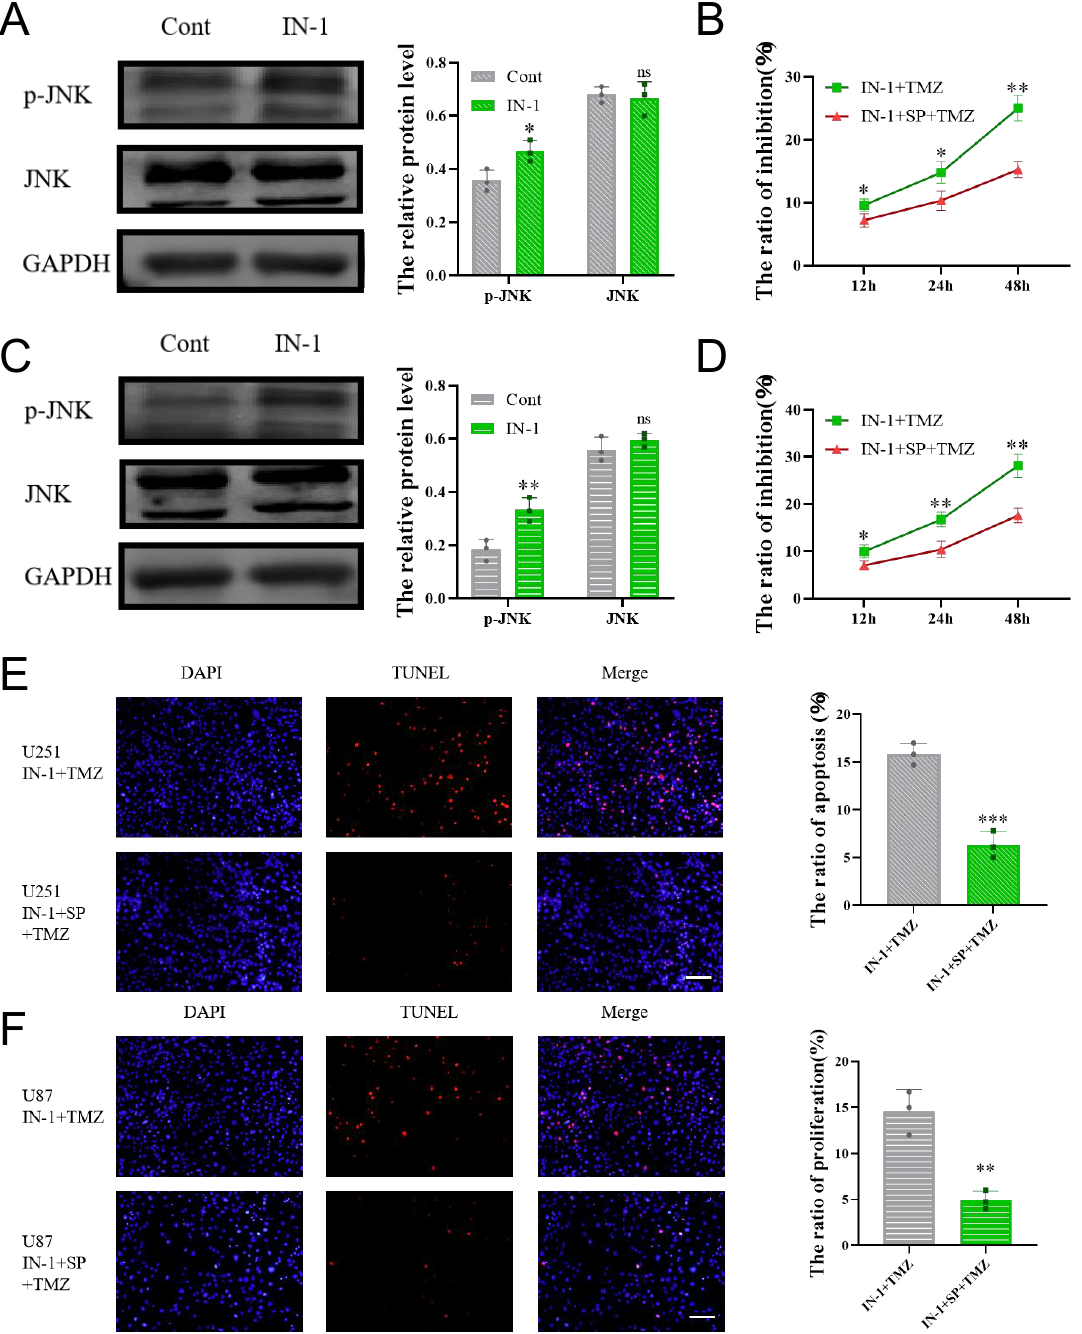
Figure 9. The dynamic changes of combined and free phytosterols in rapeseed of Dadi 199 during oil Figure 9. HPGDS promotes drug resistance in GBM by inhibiting JNK activation. ( A , C ) Inhibiting processing with/without microwave pretreatment of rapeseed. CPSs: combined phytosterols; FPSs: HPGDS significantly inhibits JNK phosphorylation. ( B , D ) CCK8 detection of the level of inhibition free phytosterols. Values are the means standard deviations; n = 3 parallel determinations. induced by SP600125 in combination with IN-1 and TMZ in U251 and U87 cells. ( E , F ) TUNEL results, ± showing that inhibiting JNK activation reduced the level of apoptosis induced by treatment with IN-1 and TMZ. * p < 0.05, ** p < 0.01, *** p < 0.001, ns: p >